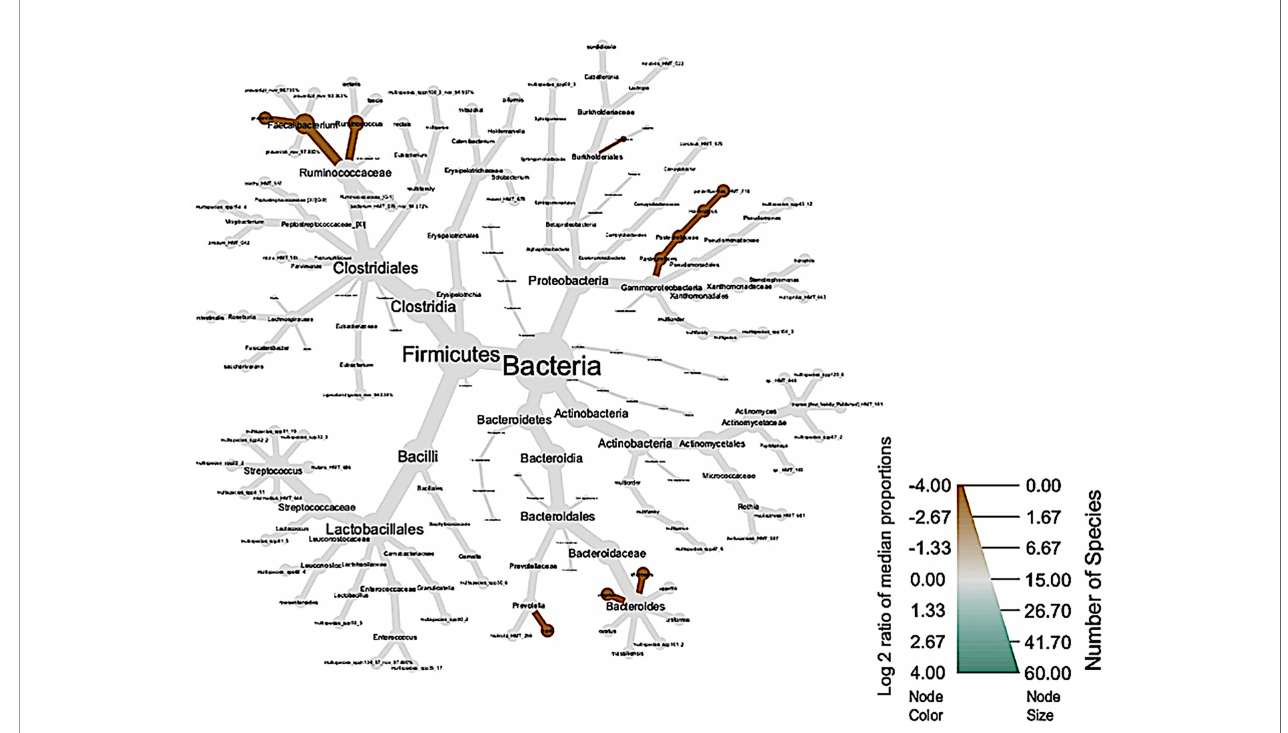
FIGURE 4 | Phylogenetic diversity of salivary microbiome in clinical diagnosis of groups with peri-implantitis (brown) and those with healthy peri-implant sites